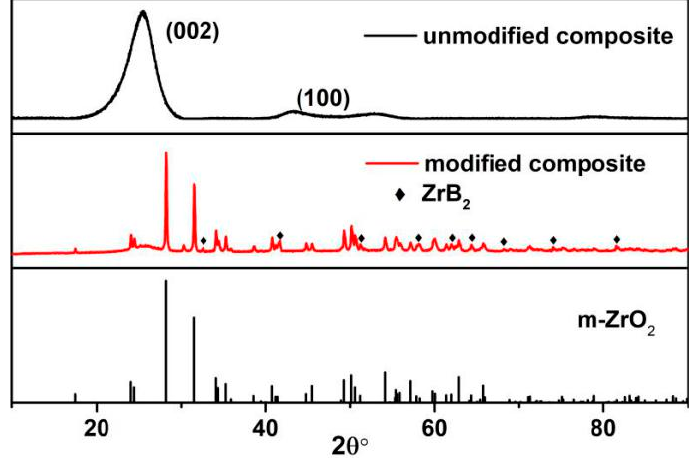
Figure 4. XRD pattern of the composite after ablation.